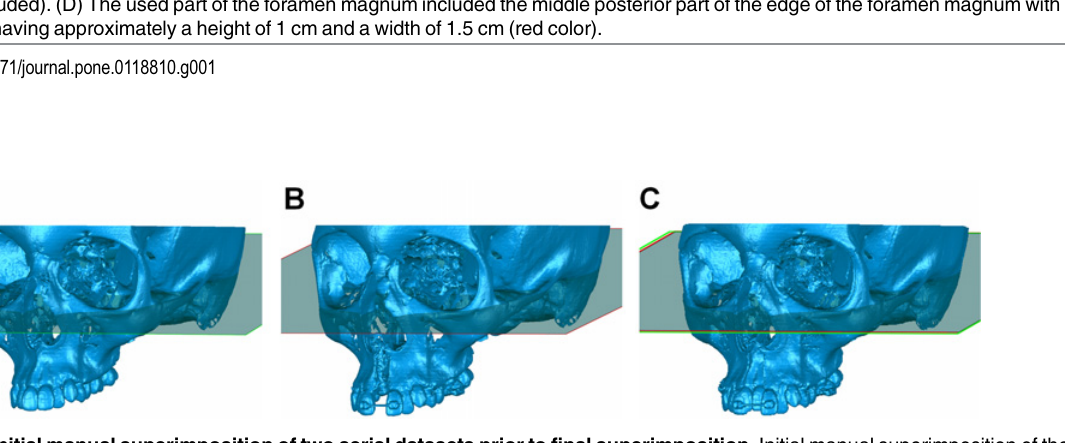
Fig 2. Initial manual superimposition of two serial datasets prior to final superimposition. Initial manual superimposition of the two models on certain stable structures or points was performed to shorten the time needed for the subsequent automatic superimposition. Thus, pairs of models were oriented and roughly registered by using the FH-plane and a line delimited by the infraorbital foramina as shown in the images. (A) Pre-treatment model, (B) post-treatment model, and (C) initially registered models.